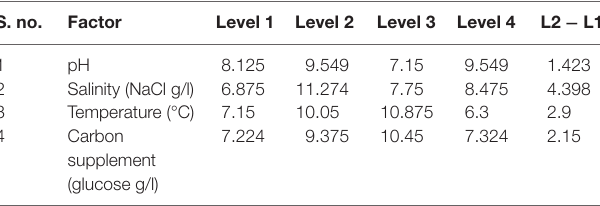
TaBle 4 | Main effects of selected factors on neutral lipids synthesis.